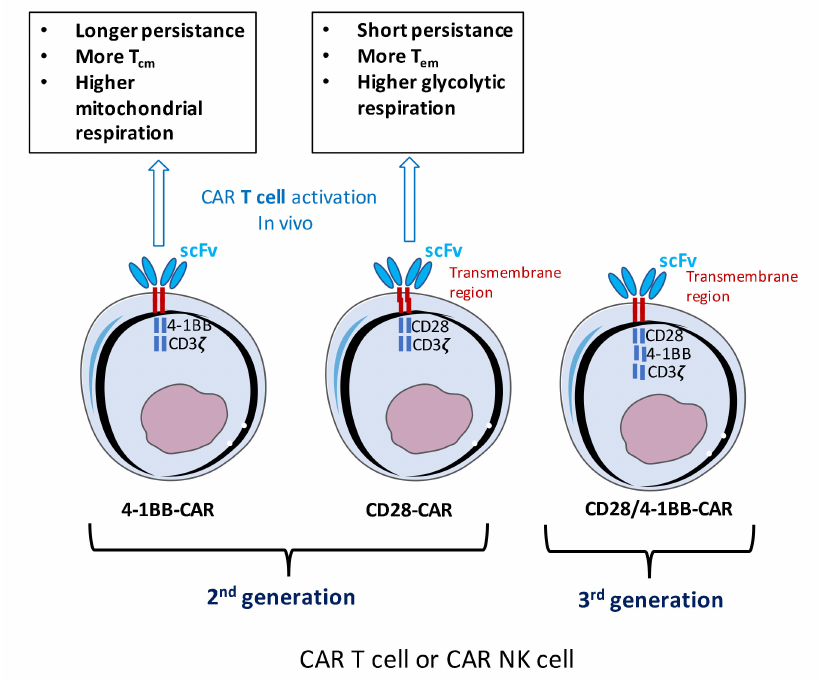
Figure 1. Chimeric antigen receptor (CAR) T cell engineering using di ff erent CAR designs and their in vivo persistence. Second-generation CAR T cells containing a CD3 zeta signaling domain, a CD28 or 4-1BB co-stimulatory domain and a scFv that will be displayed at the surface of the T cell for anti-cancer antigen recognition. For the second-generation CARs is indicated their dependence on a metabolic pathway and their persistence in vivo according to the co-stimulatory domain used. The third generation CAR contains 2 co-stimulatory